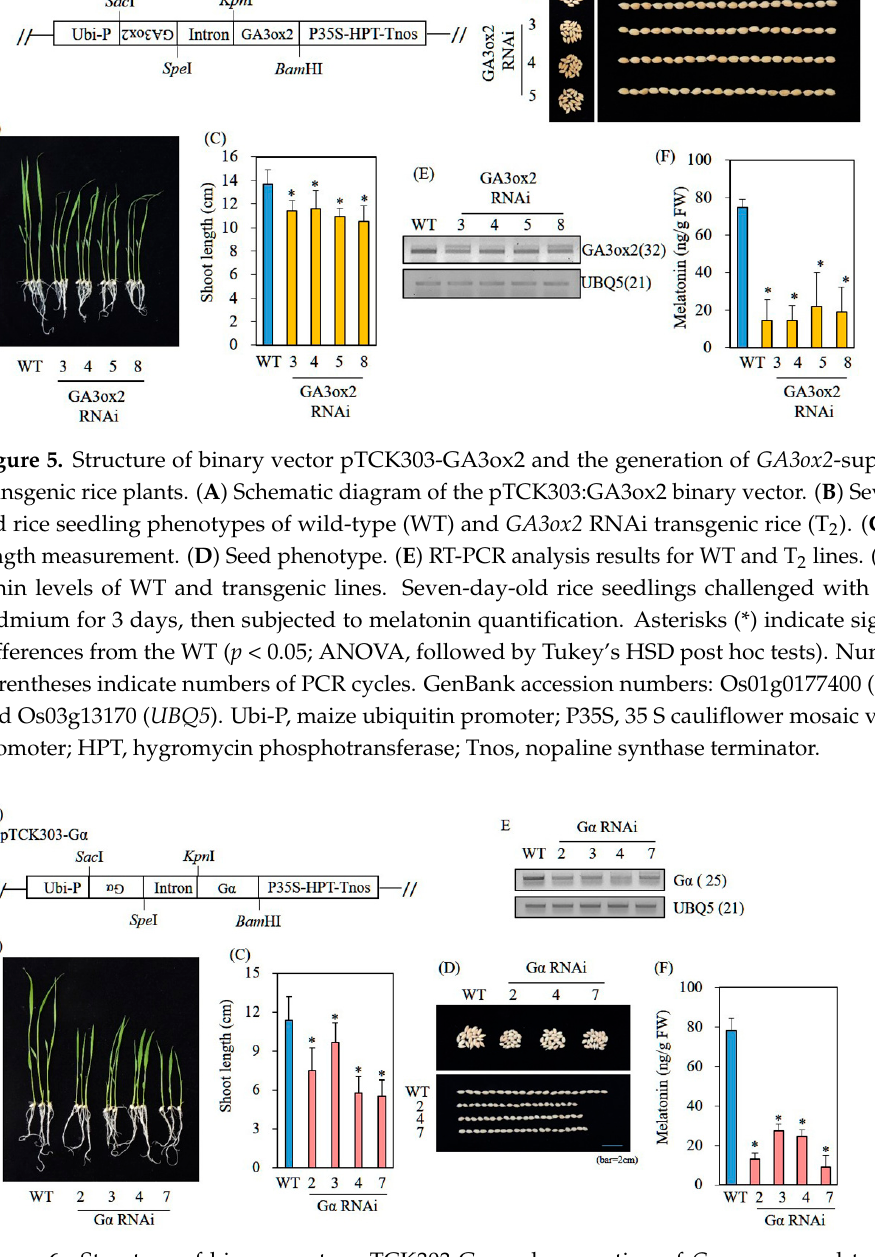
Figure 6. Structure of binary vector pTCK303-G α and generation of G α -suppressed transgenic rice plants. ( A ) Schematic diagram of pTCK303:G α binary vector. ( B ) Seven-day-old rice seedling phenotypes of WT and G α RNAi transgenic rice (T 2 ). ( C ) Shoot length measurement. ( D ) Seed phenotype. ( E ) RT-PCR analysis results for WT and T 2 lines. ( F ) Melatonin levels of WT and T 2 lines. Seven-day-old rice seedlings challenged with 0.5 mM cadmium for 3 days and then subjected to melatonin quantification. Asterisks (*) indicate significant differences from WT ( p < 0.05; ANOVA, followed by Tukey’s HSD post hoc tests). Numbers in parentheses indicate the numbers of PCR cycles. GenBank accession numbers: D38232 ( G α ) and Os03g13170 ( UBQ5 ). Ubi-P , maize